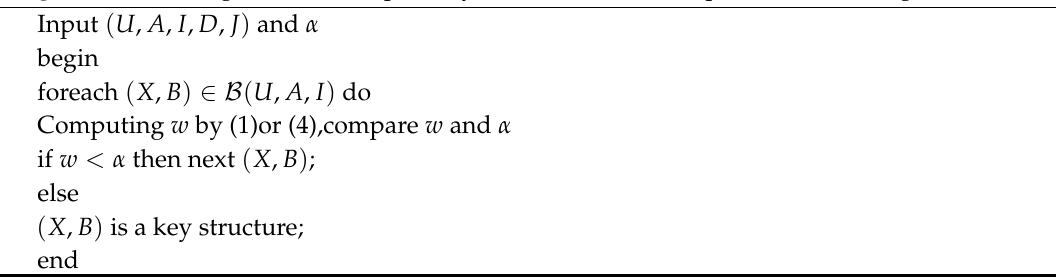
Algorithm 2: An algorithm of the part key structure with concept lattice